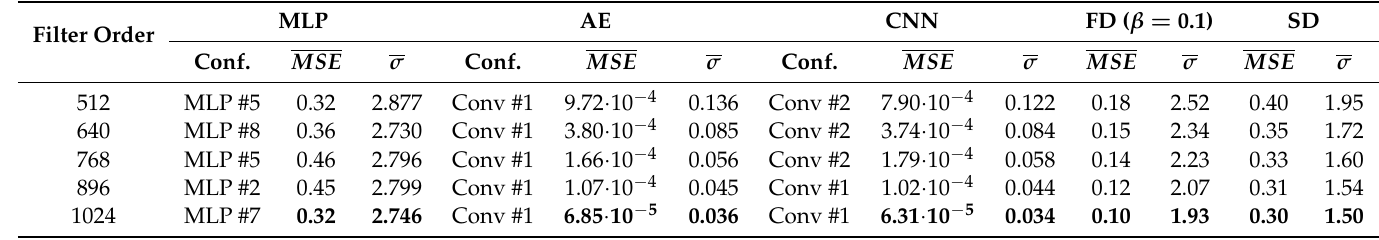
Table 2. Audio equalization results for the Alfa Romeo Giulia with binaural microphones. Please note that the MSE in the absence of equalization is 2.19, with σ 3.52. Best results for each column are highlighted in